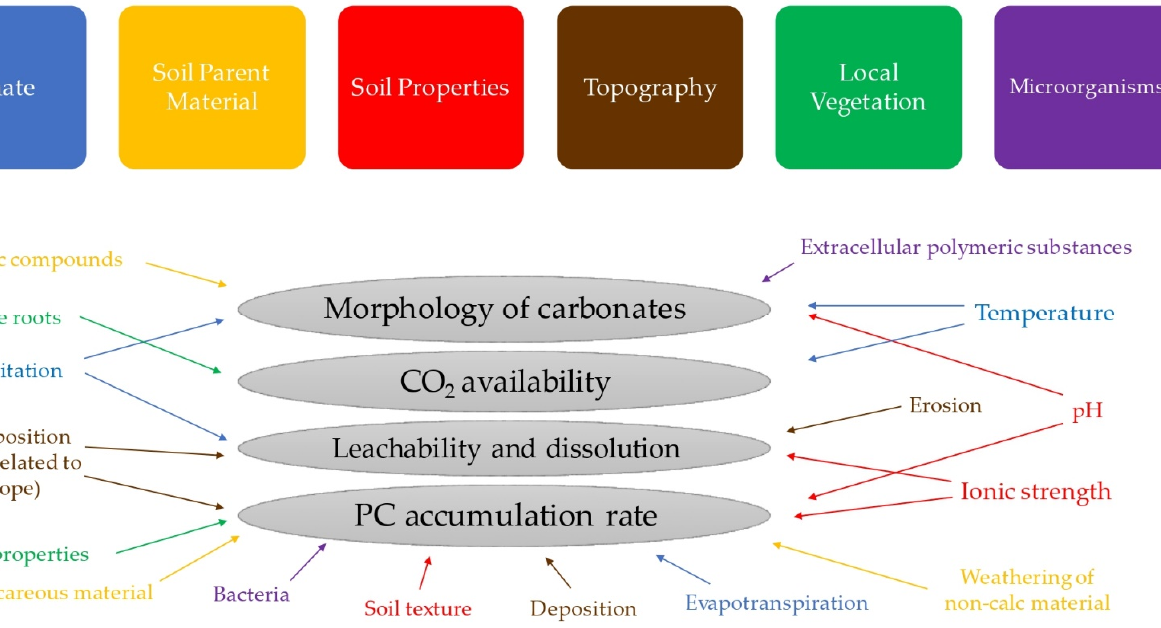
Figure 1. Illustration of environmental factors affecting PC migration and accumulation in soil discussed in Zamanian et al. [4].